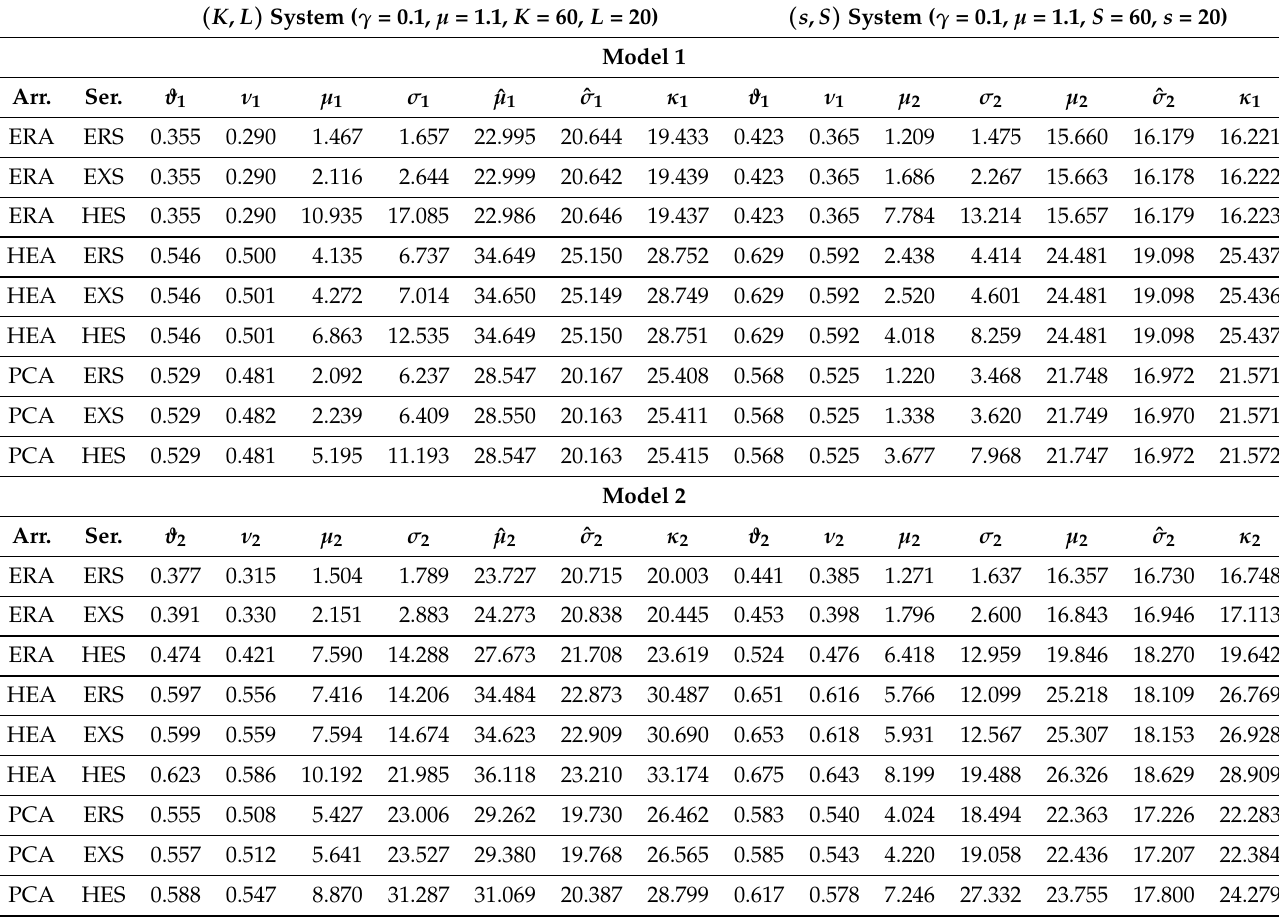
Table 5. Comparing the ( K , L ) system with the ( s , S )